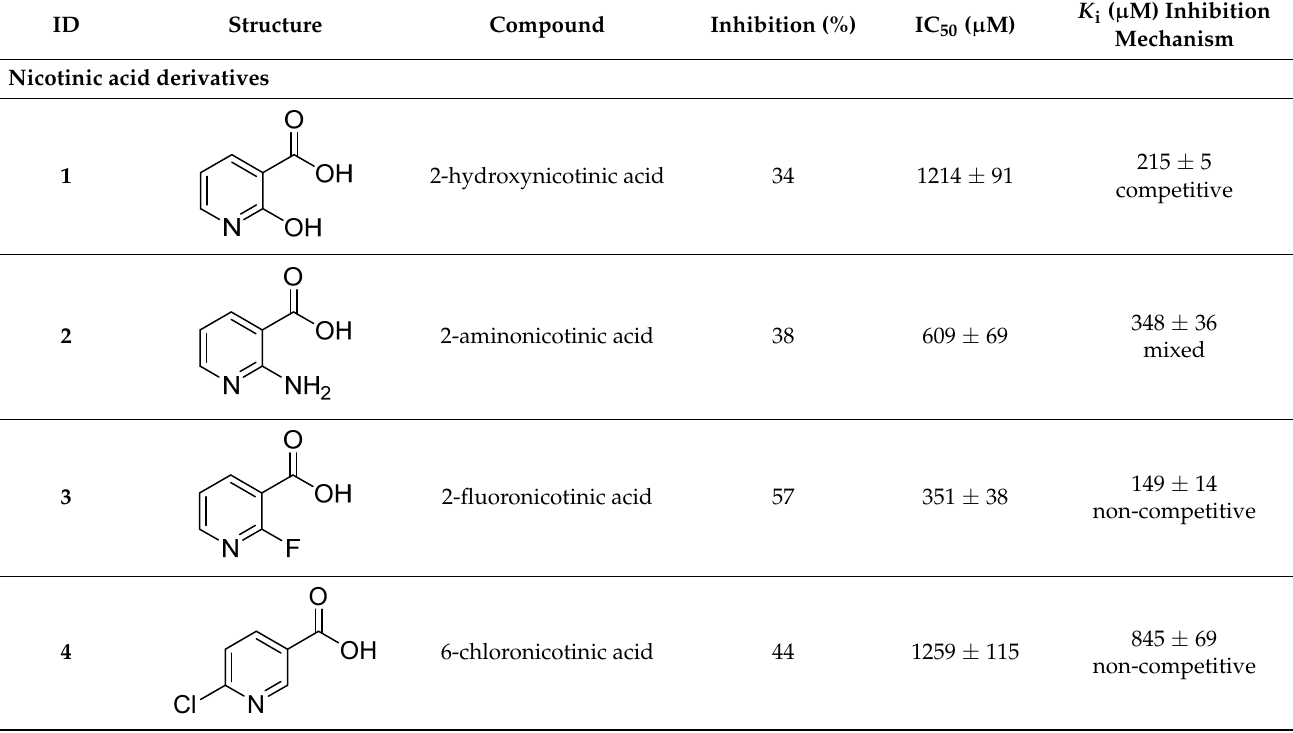
Table 1. Screening of selected compounds as possible NAPRT inhibitors 1 . ID Structure